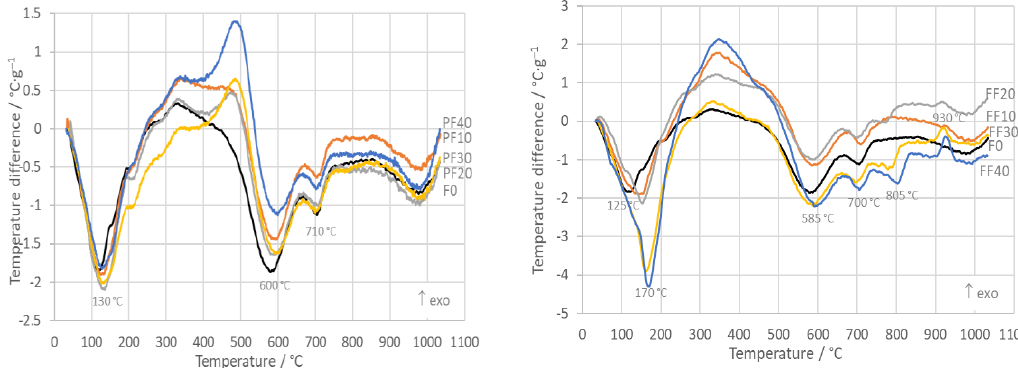
Figure 1. Di ff erential thermal analysis (DTA) of PF ( left ) and FF ( right ) Figure 1. D ifferential thermal analysis (DTA) of PF ( left ) and FF ( right ) samples.